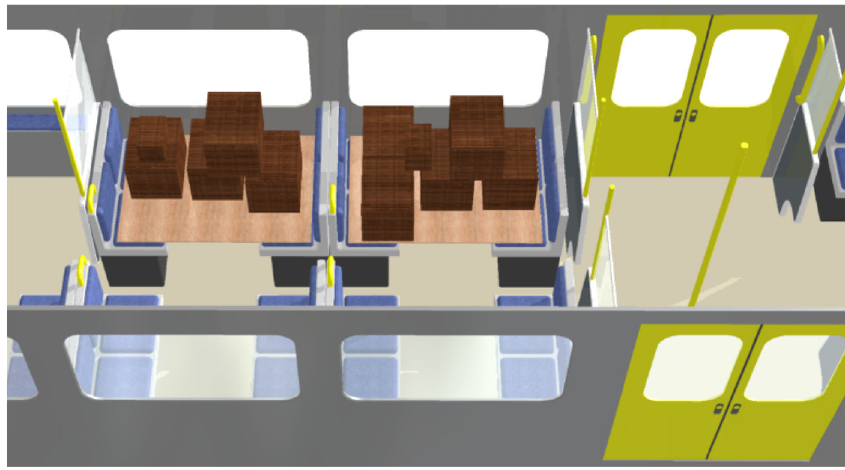
Fig. 9 Design 1.2